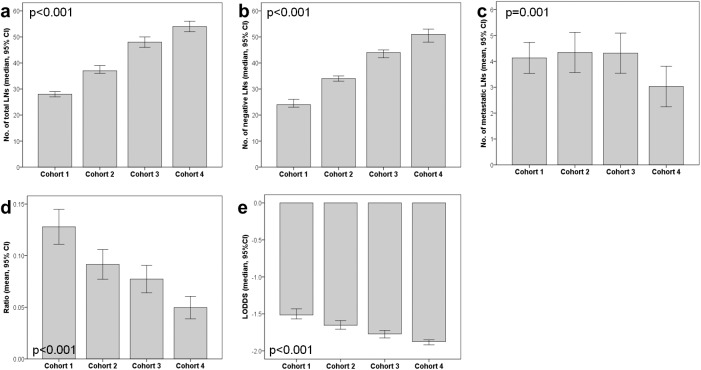
Numbers of total LNs (a), numbers of negative LNs (b), numbers of metastatic LNs (c), metastatic lymph node ratio (MLR) (d), and log odds of positive lymph nodes (LODDS) (e) among four cohorts were plotted by bar charts and analyzed by Kruskal-Wallis H tests